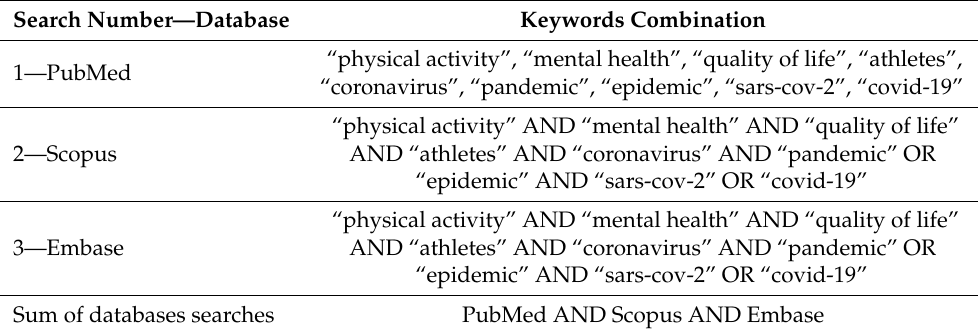
Table 2. Key words used in the process of searching in the PubMed, Scopus, and Embase